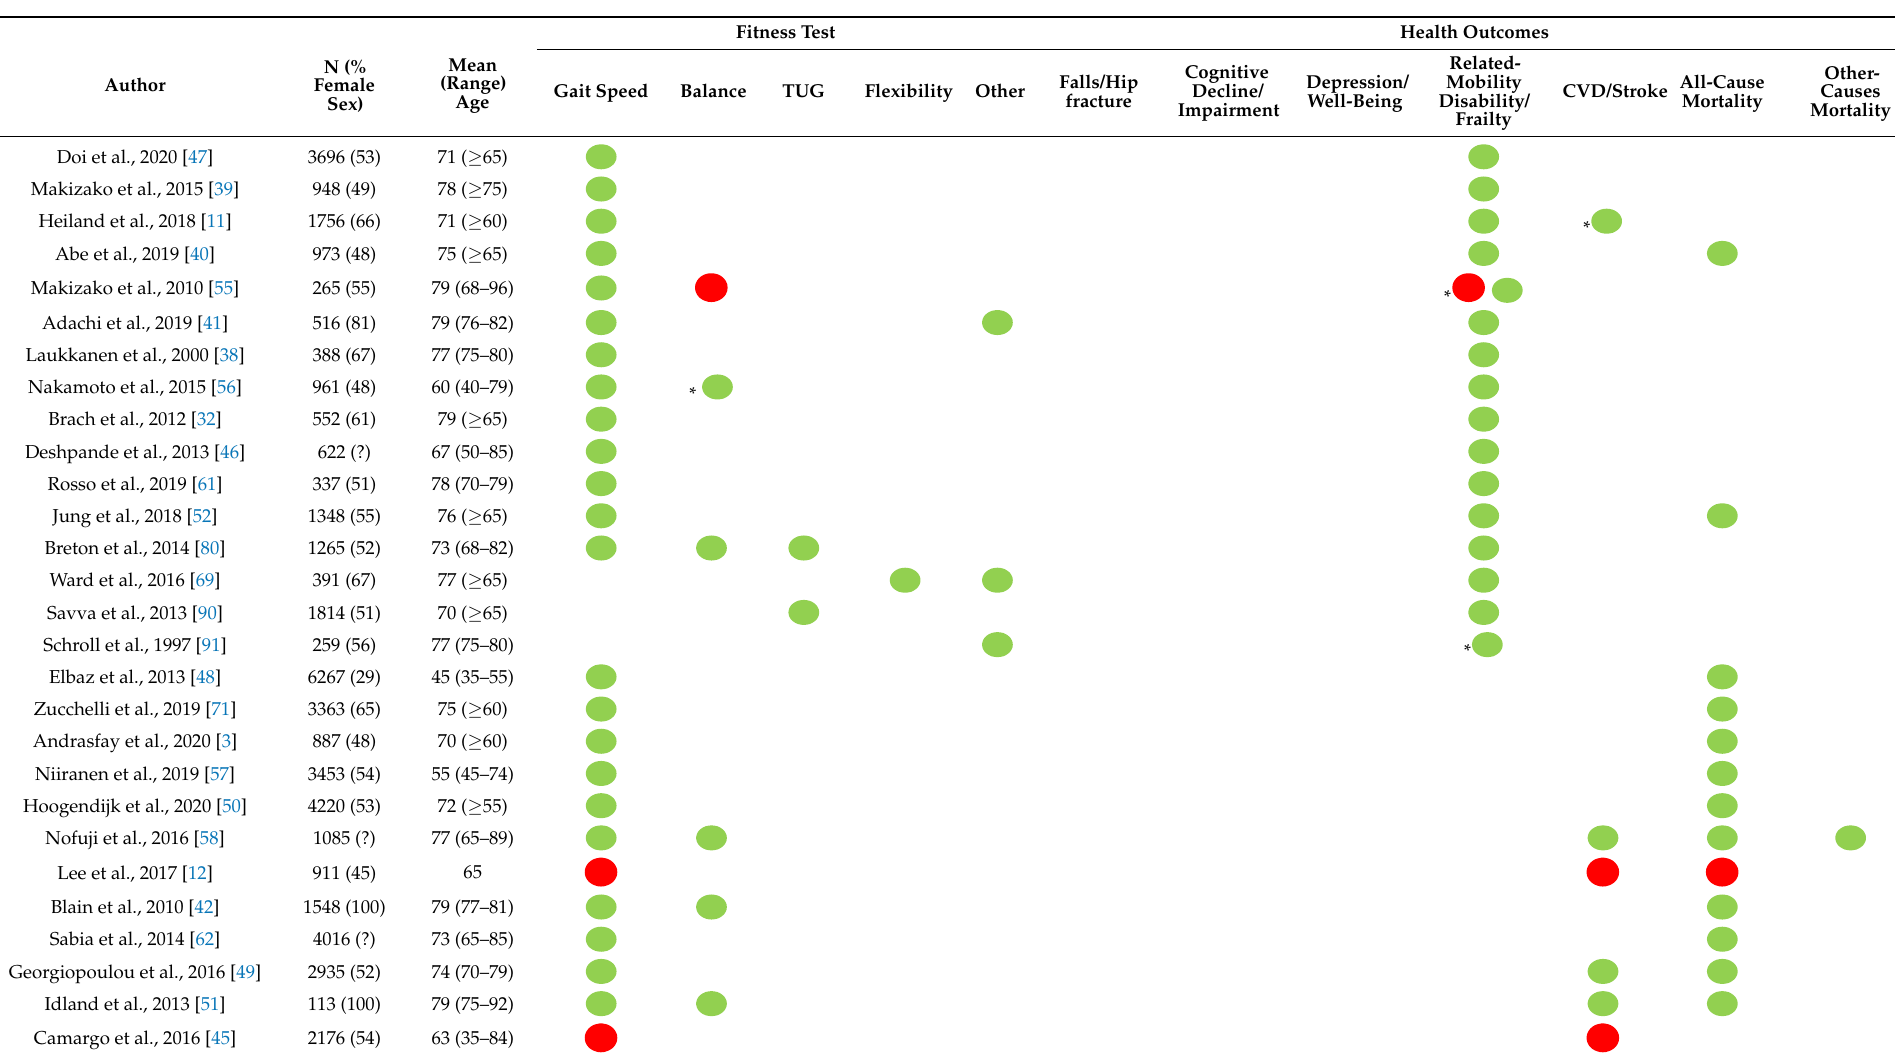
Table 3. Main characteristics and findings of longitudinal studies investigating the predictive validity of motor fitness and flexibility tests for health outcomes in adults and older adults.